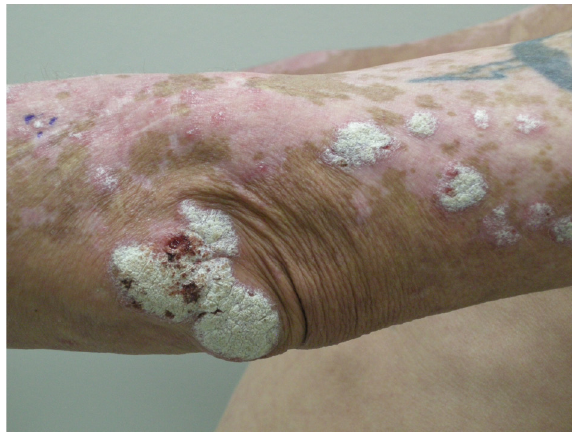
Figure 1. Clinical photo of hypertrophic lupus erythematosus. Hypertrophic lupus erythematosus presenting as a verrucous plaque on the patient’s